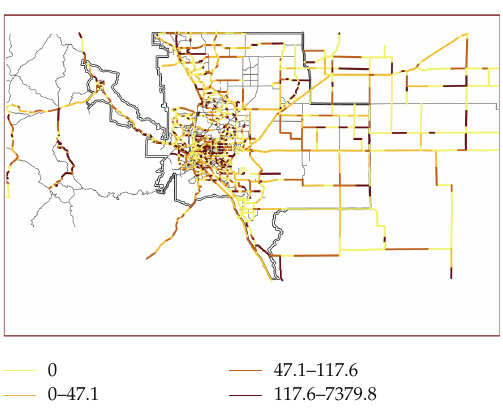
Figure 1: Road segment crash rate distribution in terms of the number of crashes per 100 million VMT.